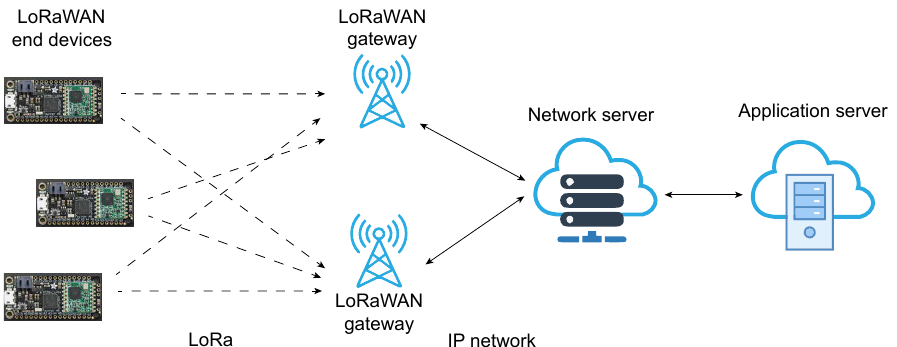
Figure 2. LoRaWAN (Long Range Wide Area Network) architecture.